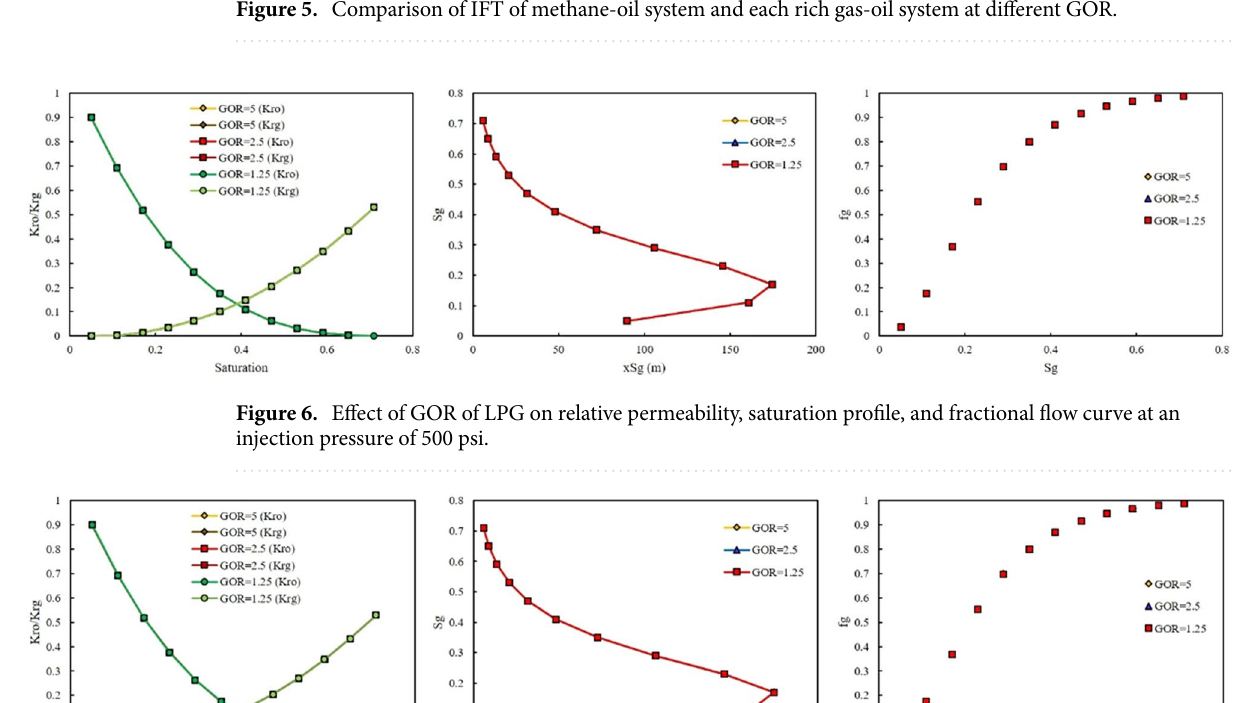
Figure 5. Comparison of IFT of methane-oil system and each rich gas-oil system at different GOR.